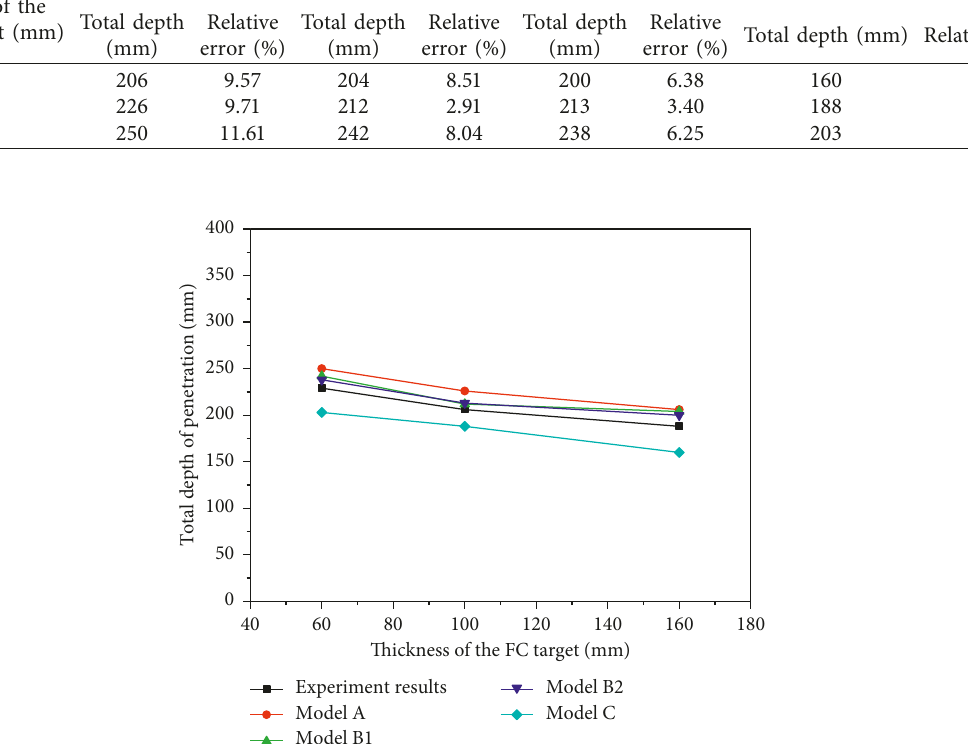
Figure 16: Depth of penetration results of numerical simulation and